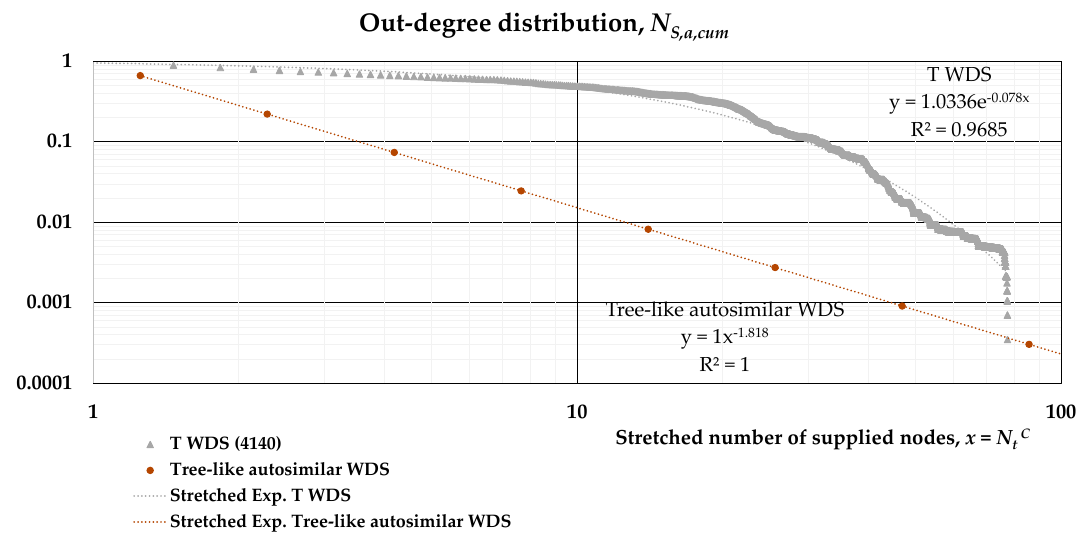
Figure 5. Cumulative out-degree distribution functions for T WDS, with stretched exponential fitting.